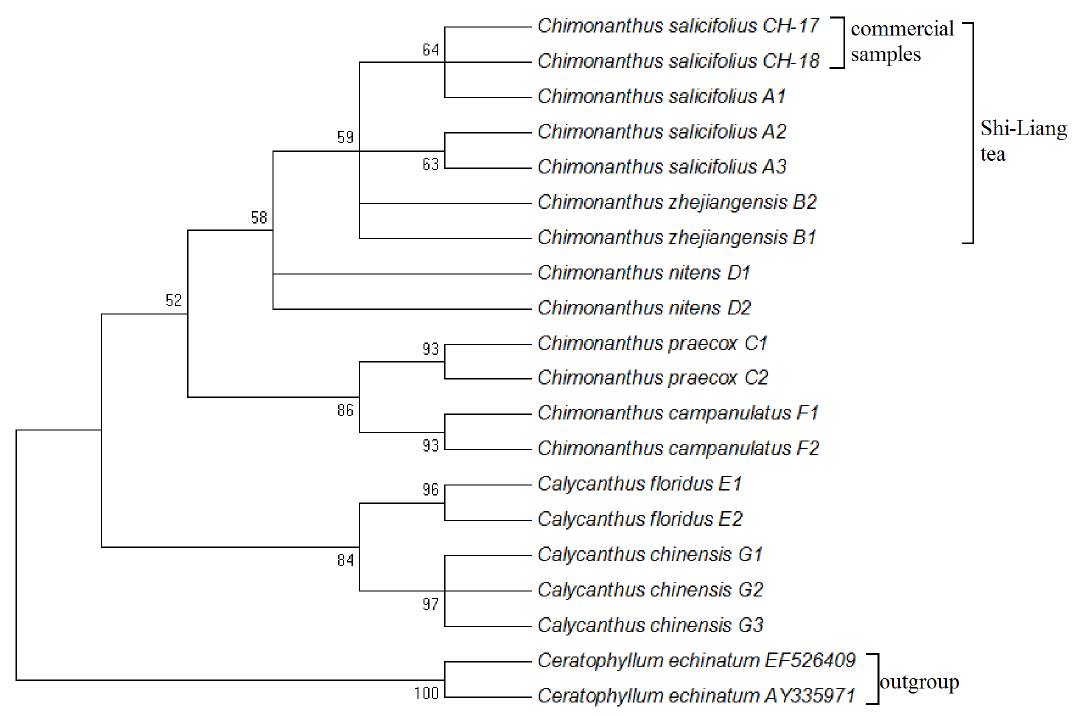
Figure 1. The NJ ‐ tree of Shi ‐ Liang tea and its closely related species. Figure 1. The NJ-tree of Shi-Liang tea and its closely related